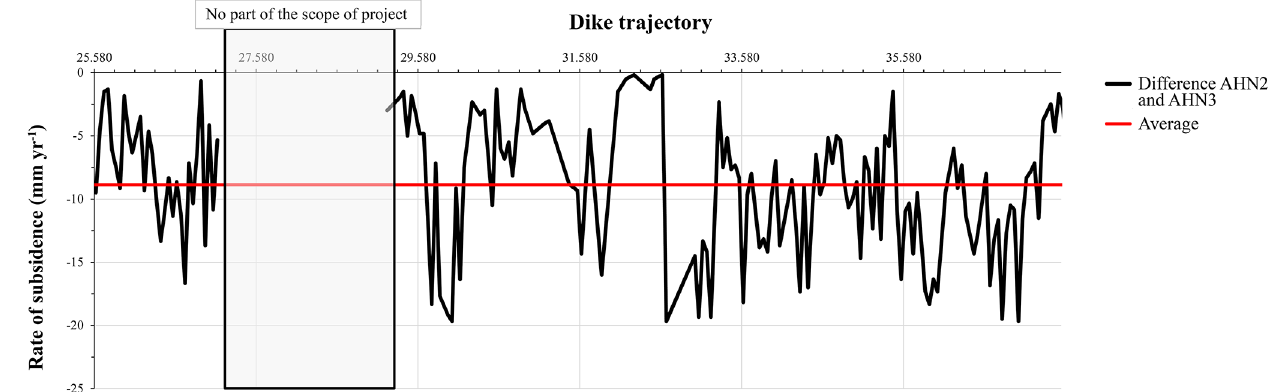
Figure 4. Determination of average subsidence rate based on difference in LiDAR data from 2008 and 2014.